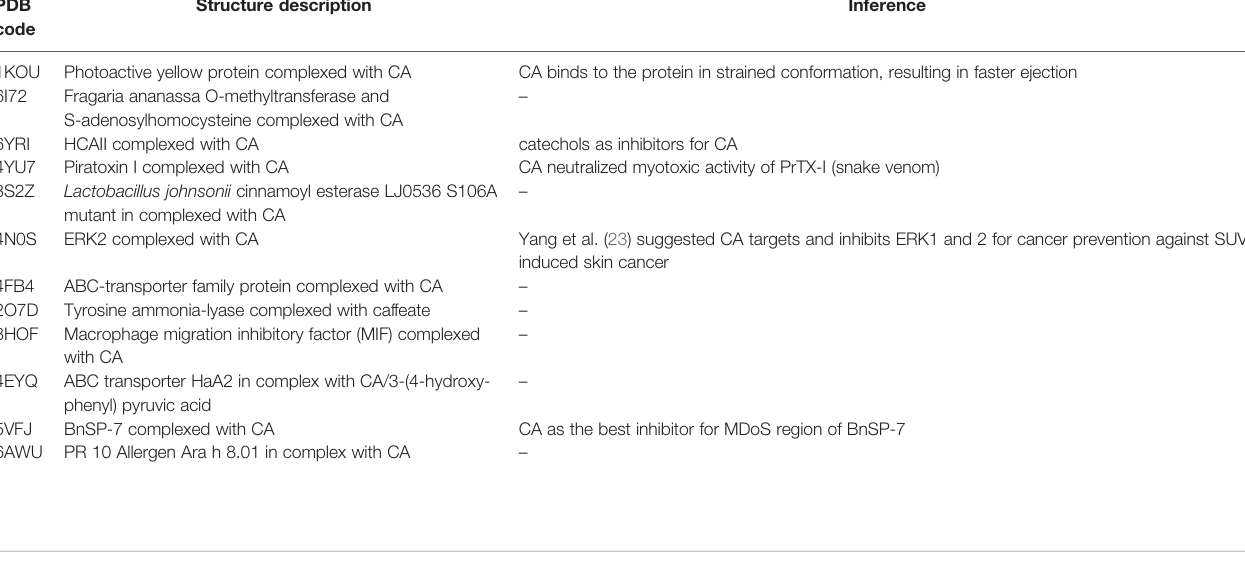
TABLE 3 | List of protein-bound 3D structures complexed with caffeic acid and inferences on binding af fi nity. PDB code